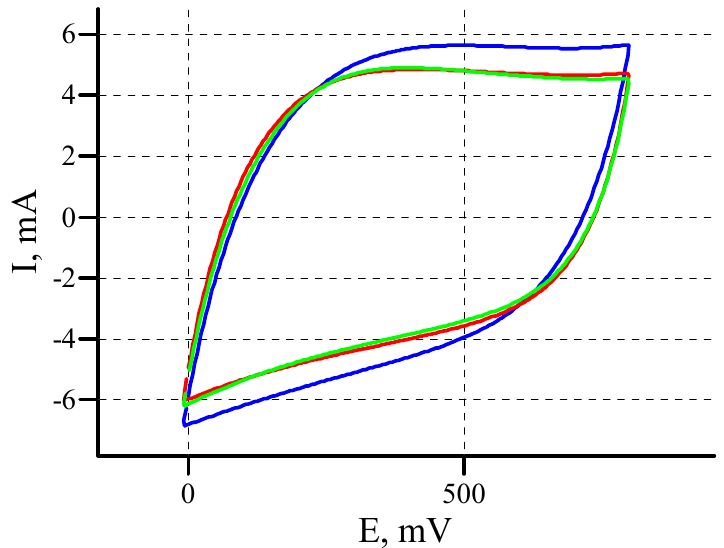
Figure 10. Multiple CVs of the oxidized MWCNT/Al sample. Cycle number: 1—blue, 10,000—red, 20,000—green.